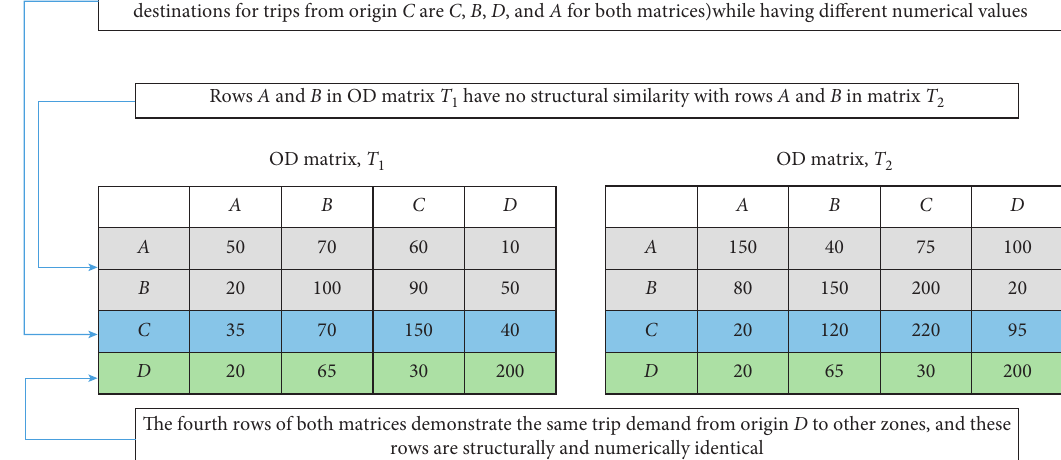
Figure 1: Two sample matrices with structural and numerical